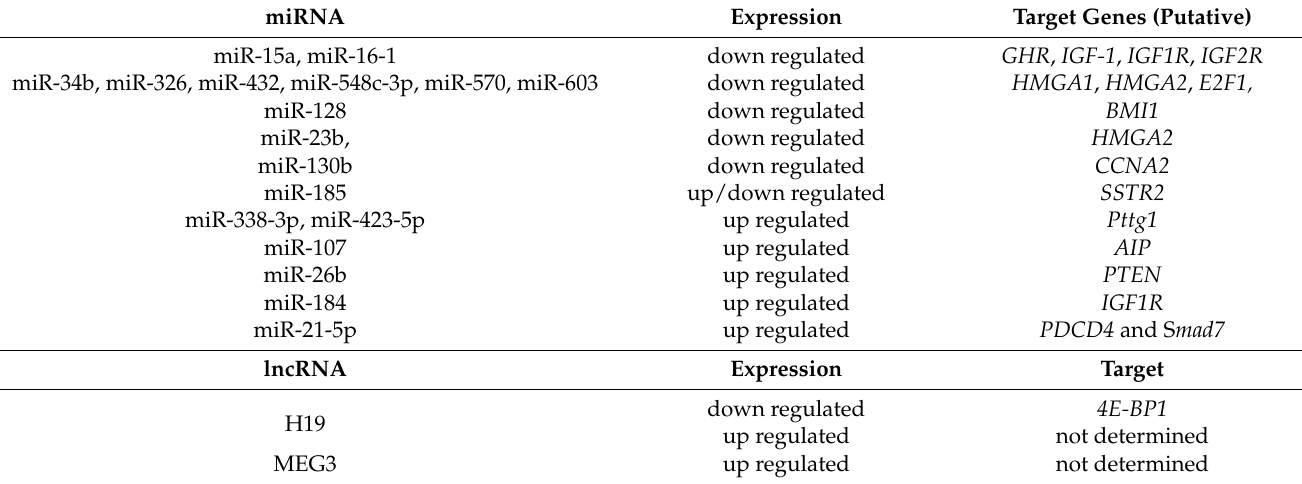
Table 2. The list of miRNAs and lncRNAs and their target mRNAs involved in the pathogenesis and characteristics of somatotroph